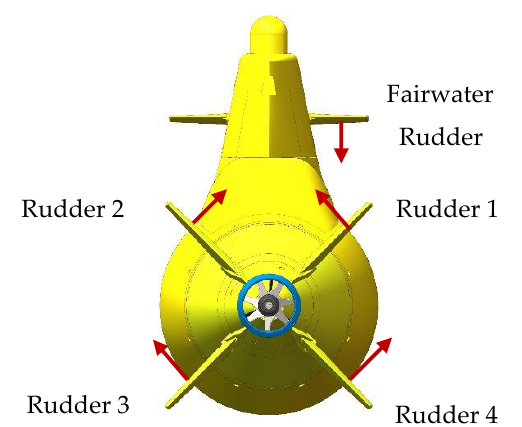
Figure 7 . Sign definition of deflection angle. The red arrow represents the positive deflection. Figure 7. Sign definition of deflection angle. The red arrow represents the positive